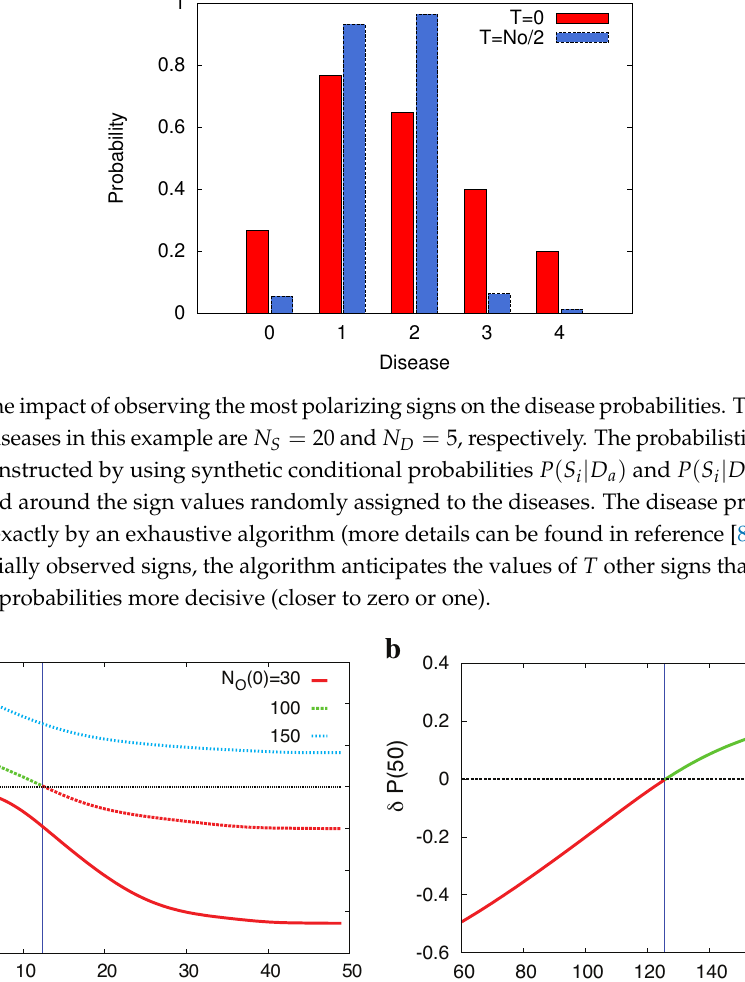
t ) P ( T W t ) between the cumulative ≤ − ≤